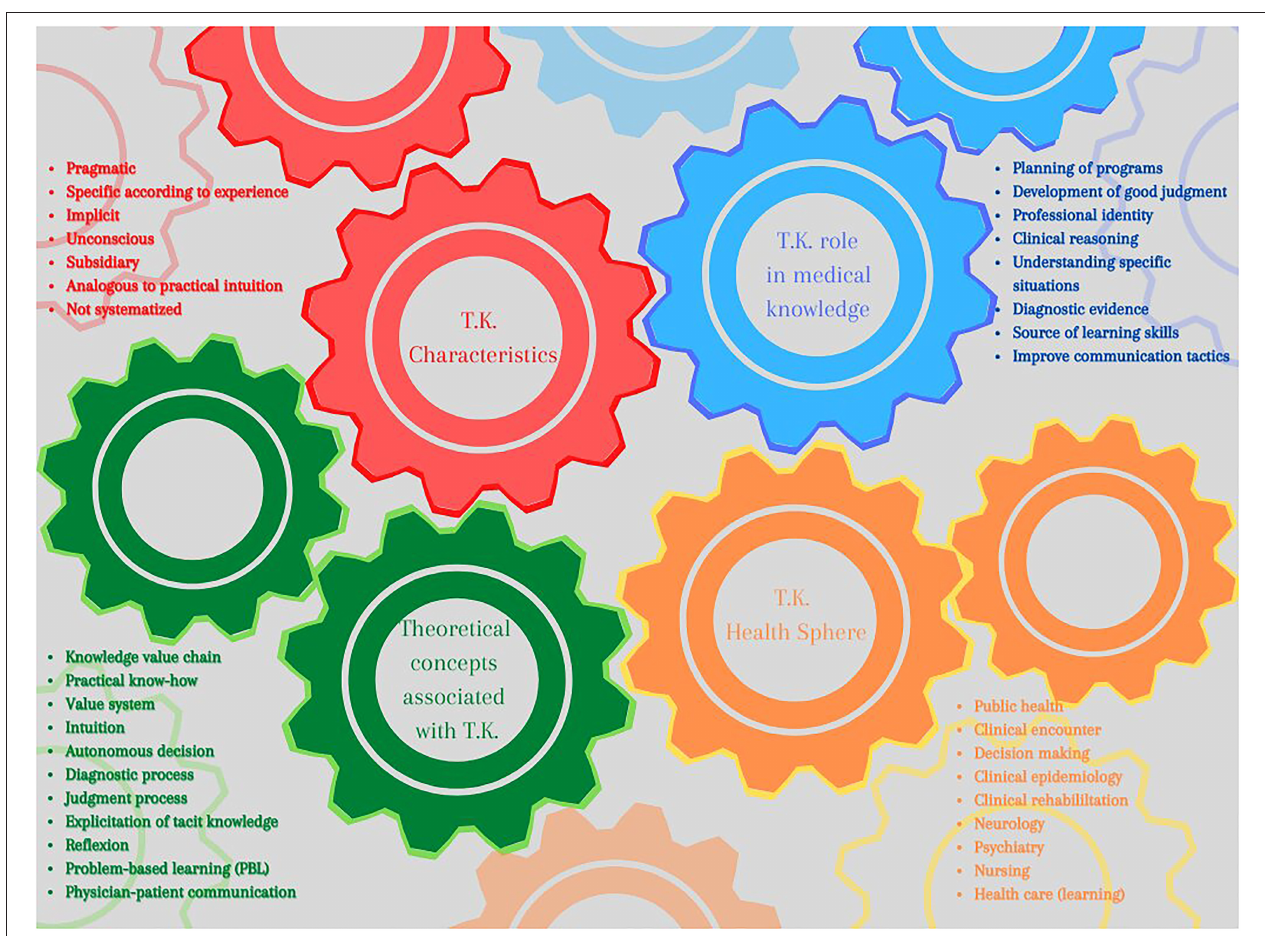
FIGURE 6 | The gears of T.K.